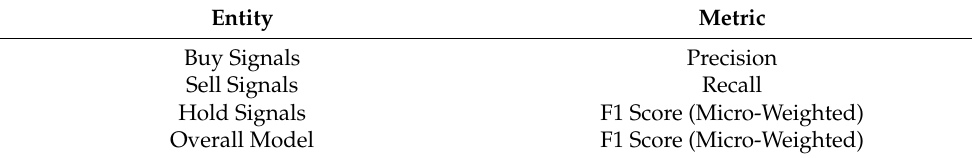
Table 4. Metrics for different